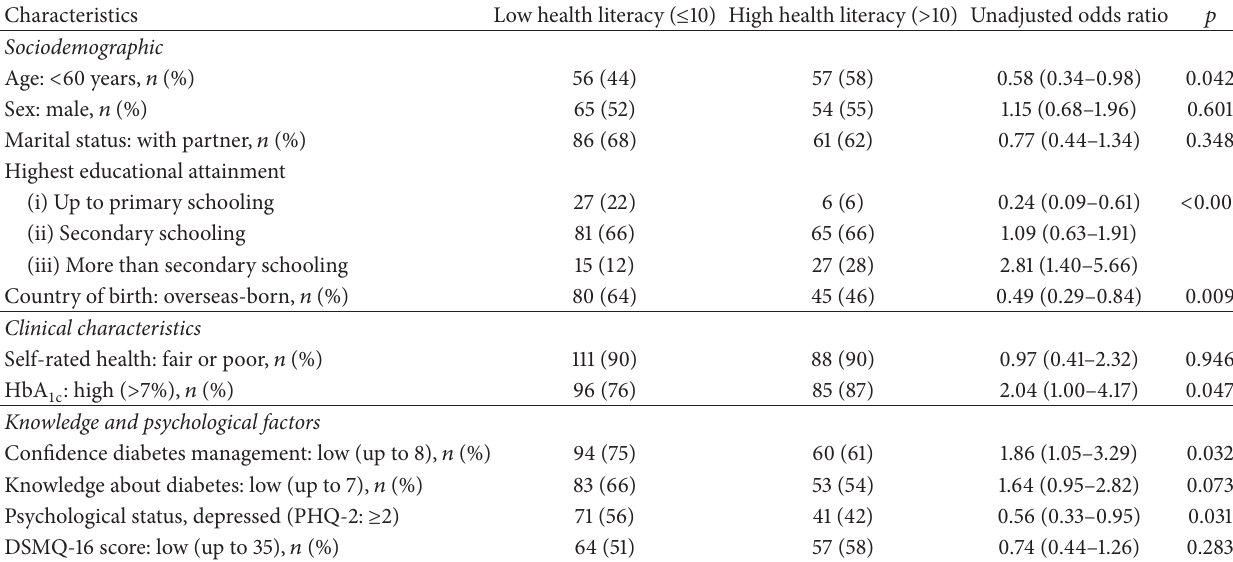
Table 2: Group comparison of high and low health literacy levels by participant characteristics.